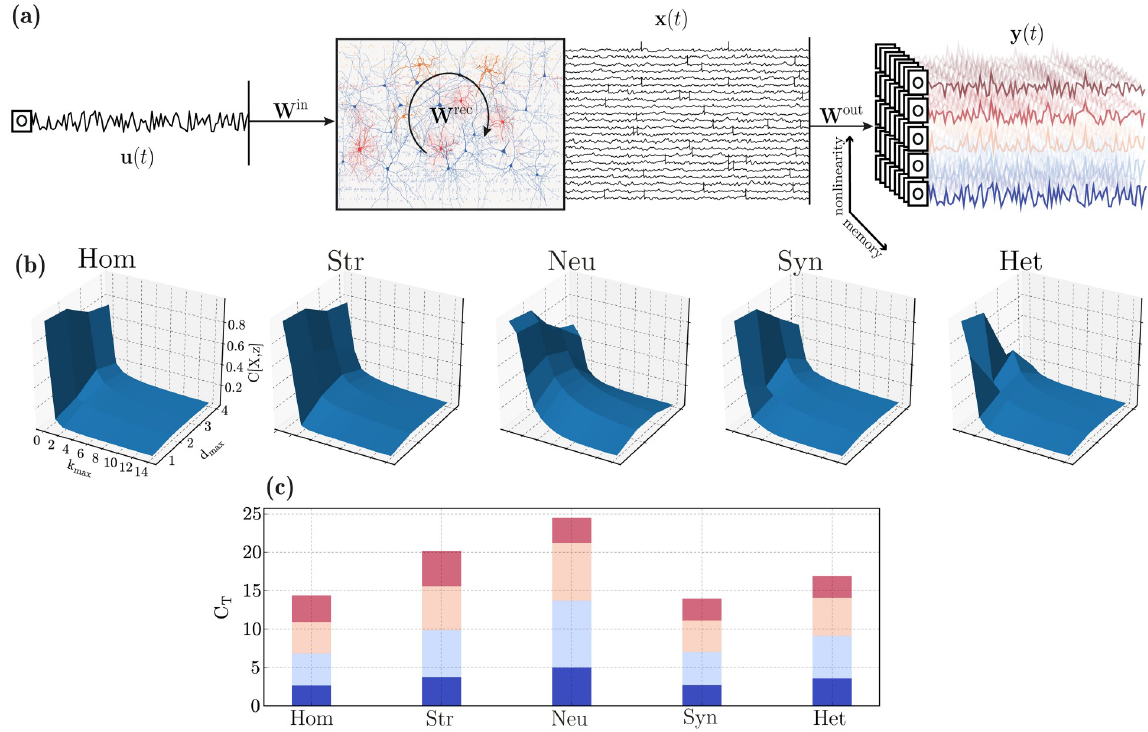
Fig 8. Computational capacity in the different heterogeneity conditions. ( a ) Illustration of the setup used to assess computational capacity. An input signal, u , is used to drive a sub-set of E neurons and the population responses, x , are recorded and gathered in state matrix X . These states are then used to reconstruct a set of time-dependent functions z = f ( u − k ). These target functions vary in complexity (degree of nonlinearity, color-coded) and memory requirements. ( b ) Normalized capacity space, i.e. ability to reconstruct functions of u at different maximum delays (k max , memory) and degrees (d max , complexity/nonlinearity). For any given function, the capacity is normalized such that C [X, z] = 1 corresponds to perfect reconstruction of z . ( c ) Total processing capacity, expressed as the sum of all capacities for a given degree (the incremental color code in each bar corresponds to the maximum degree for each segment, varying from 1 to 4 and is also illustrated in ( a )).